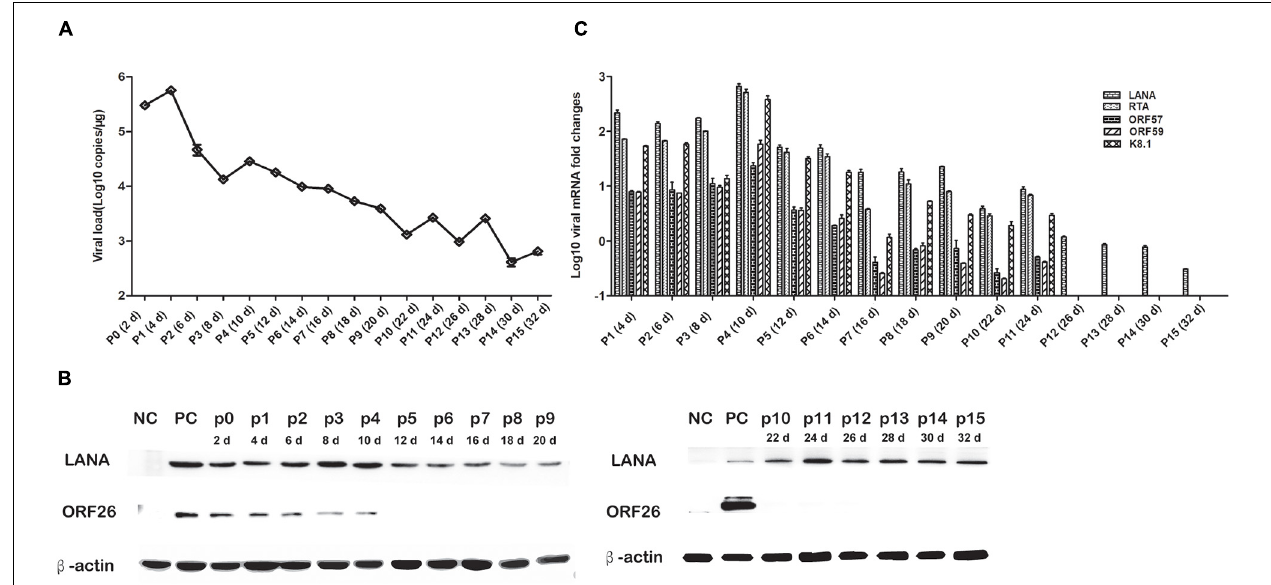
FIGURE 3 | Cell passaged rKSHV.219 inTSKEC. (A) rKSHV.219 DNA copies in TSKEC. (B) rKSHV.219 transcripts in TSKEC. (C) rKSHV.219 latency protein LANA and lytic ORF26 expression in TSKEC (NC, negative control; PC, positive control; p0, passage 0).